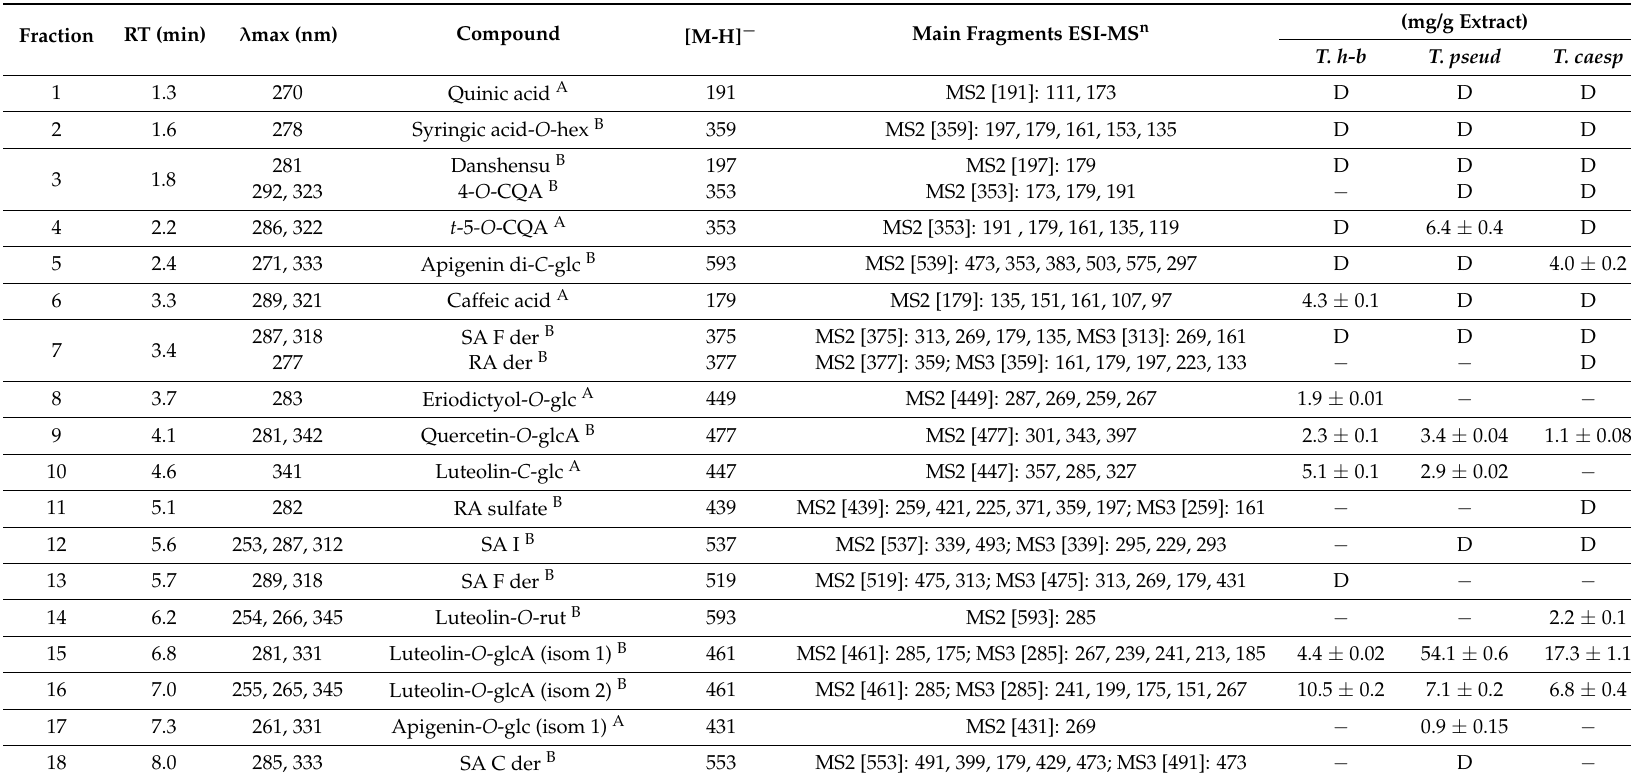
Table 2. Identification and quantification of UHPLC (ultra high performance chromatography) eluting fractions by UHPLC-DAD-MS n of T. herba-barona , T. pseudolanuginosus , and T. caespititius aqueous